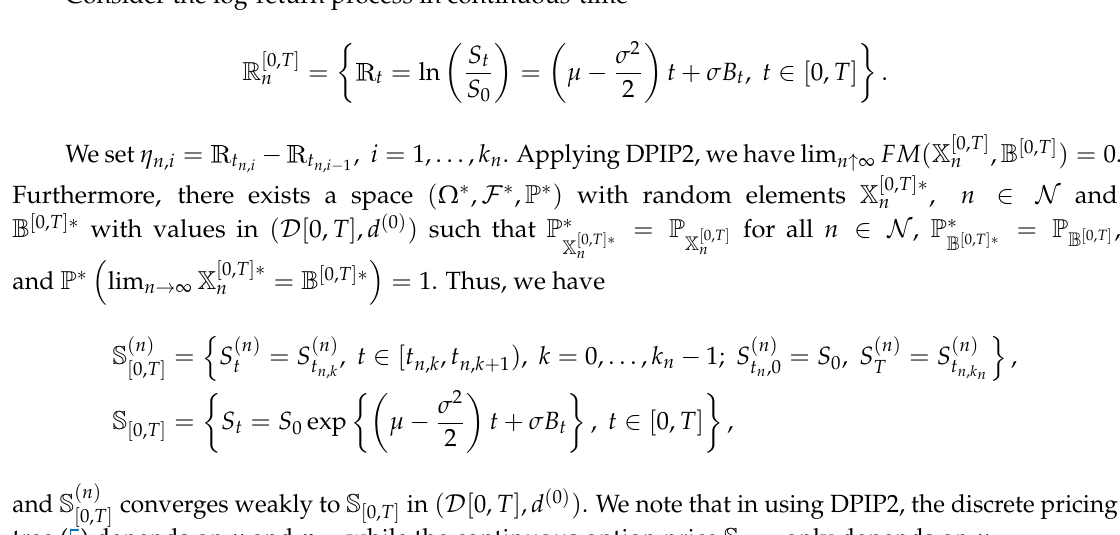
Figure 1. Convergence rate, measured as n = T / ∆ t , of S where S T is defined in (1) and S | ( S ( n ) − S ) / S | ≤ 10 − 6 T 0 T